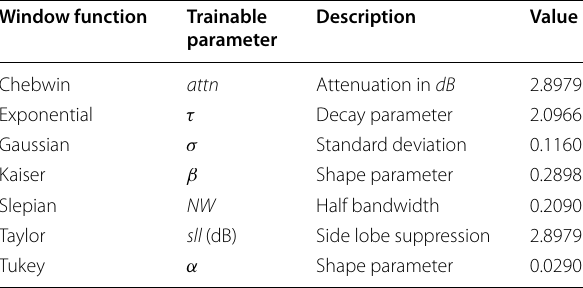
Table 3 Parameters of Group2 windows obtained after